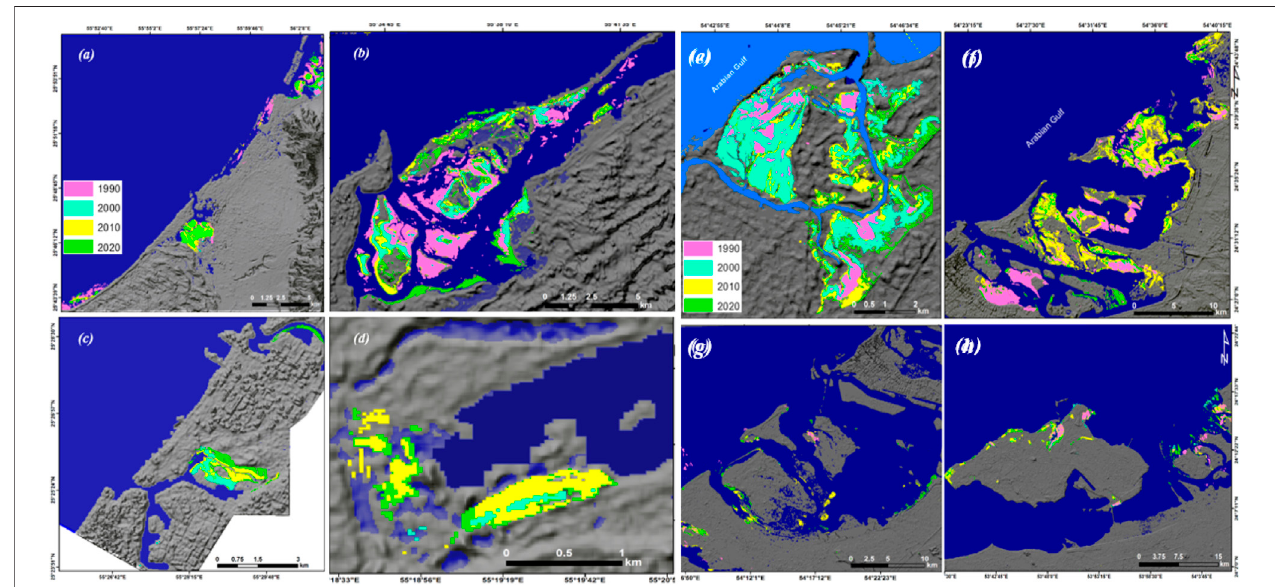
FIGURE 12 | Mangrove pattern change between 1990 and 2020 for the natural reserves of RAK (A) , Umm Al Quwain (B) , Ajman – Al Hamriya (C) , Ras Al Khor of Dubai (D) , Ras Ghandah (E) , Abu Dhabi – Saadiyat – Shlelia strip (F) , Abu Dhabi – Al Dhabiya strip (G) , and Al Dhabiya – Abu Al Abyad strip (H) .